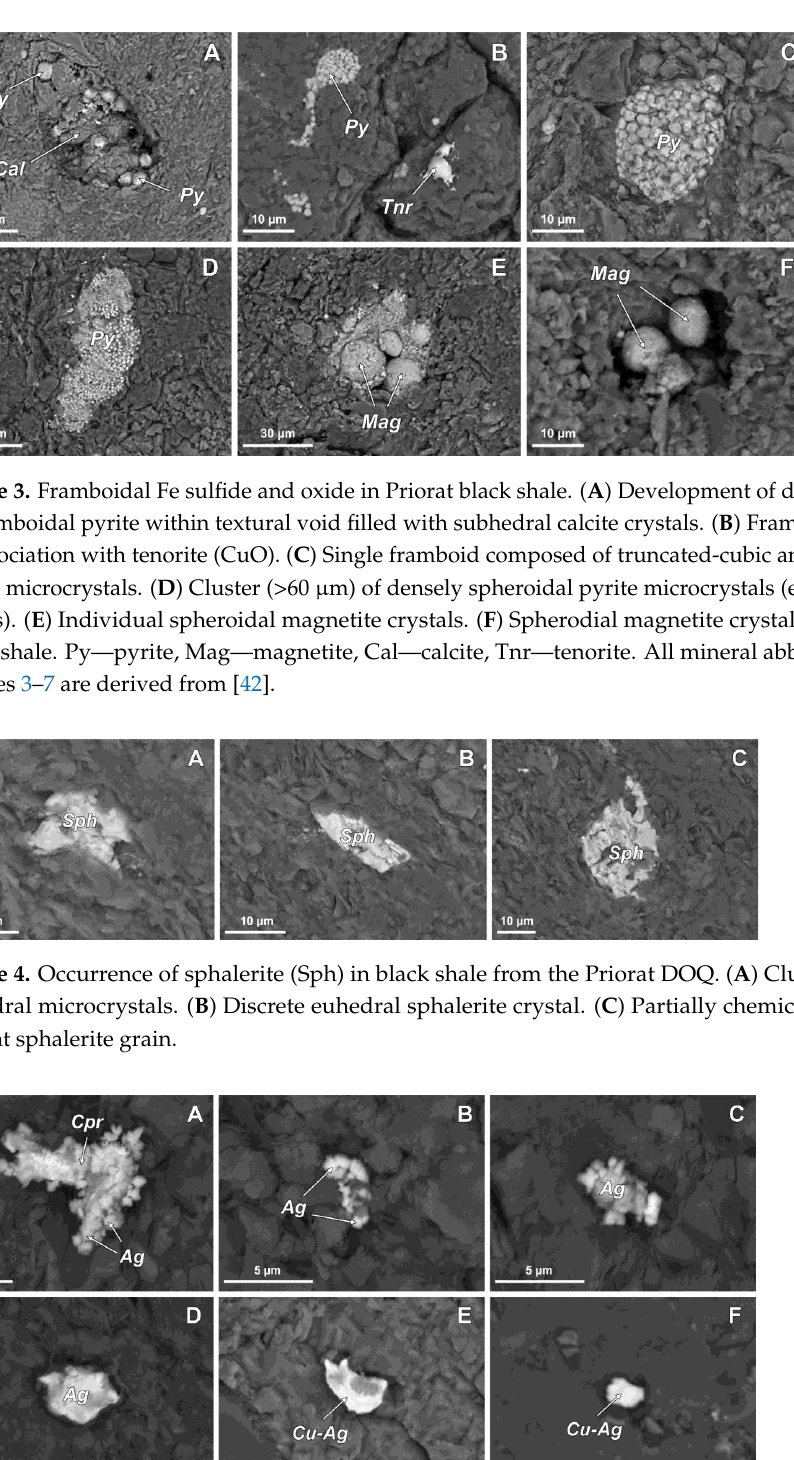
Figure 5. Occurrence of native and cupriferous silver in black shale from the Priorat DOQ. ( A ) Cluster of small (<10 µm) euhedral cuboid silver (Ag) microcrystals intergrown with cuprite (Cpr). ( B ) An aggregate of anhedral to subhedral silver grains in the feldspar-sericite matrix. (C ) An aggregate of almost globular (less than 1 µm) silver (with minor Cl = 2.13 wt.%; chlorargyrite micro-inclusion?) microcrystals. ( D ) Discrete euhedral sub-equant cupriferous (Cu = 4.1 wt.%) silver (Cu – Ag) grain. (E) Cupriferous (Cu = 2.26 wt.%) silver film mantling feldspar (?) grain. (F) Euhedral equant cupriferous (Cu = 1.94 wt.%) silver (Cu – Ag) micro-crystal in carbonaceous matrix.